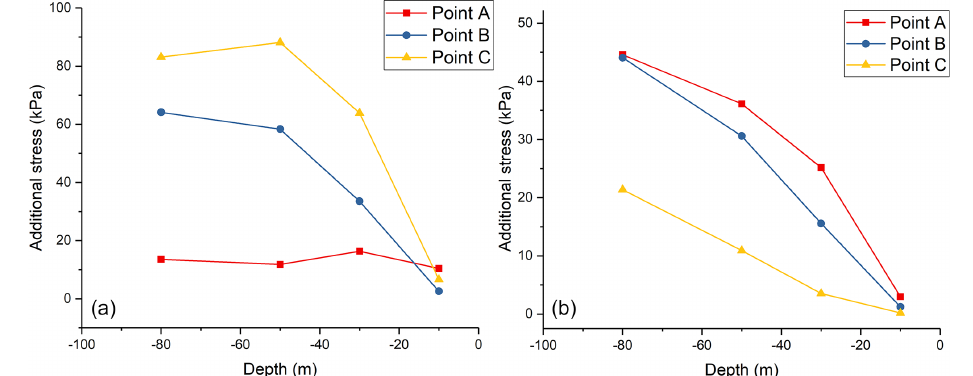
Figure 3. (a) Additional stress derived from building loads at different depths of Group 1 characteristic points. (b) Additional stress derived from building loads at different depths of Group 2 characteristic points.